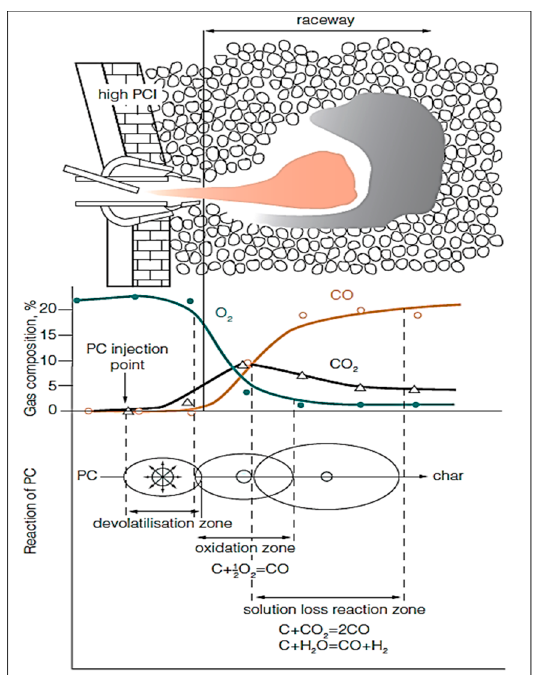
Figure 5. Schematic diagram for PC reactions in raceway (adopted with permission from [95]).